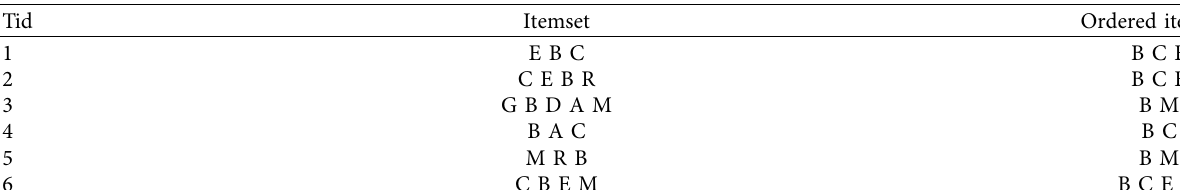
Table 7: Database D3 at